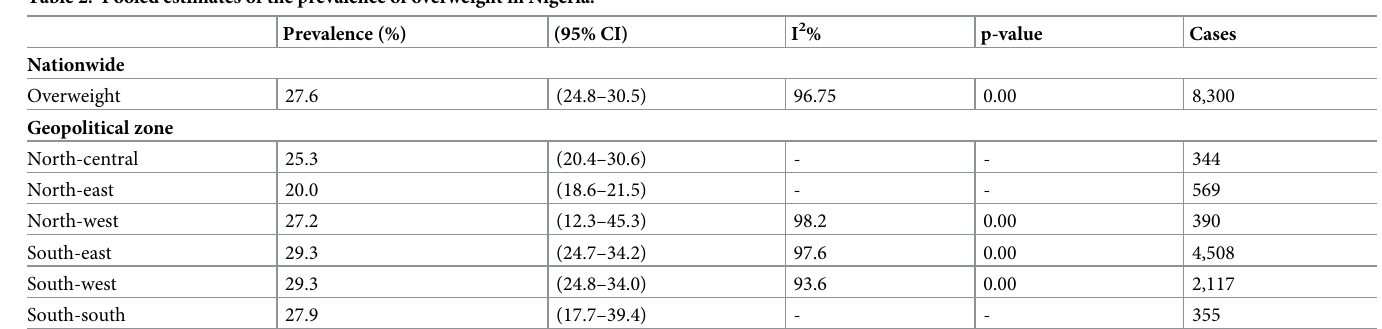
Table 2. Pooled estimates of the prevalence of overweight in